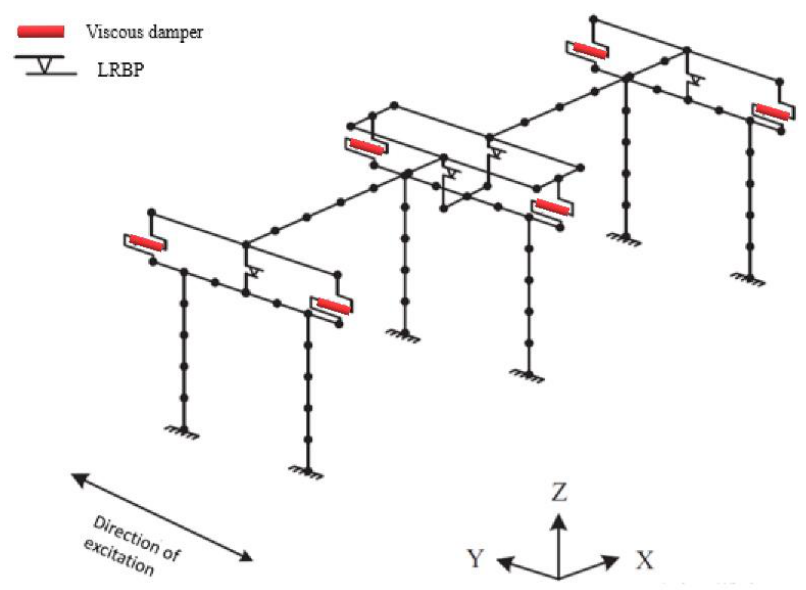
Figure 14. Finite element modeling of the bridge with the location of viscous dampers and LRBPs.